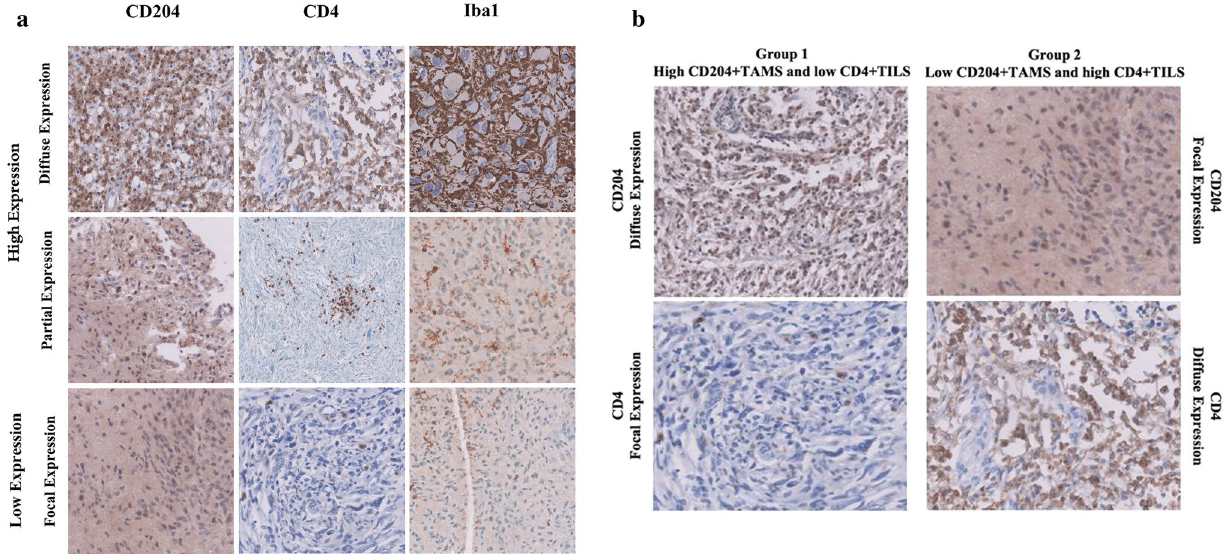
Fig. 1 Quantitative assessment of CD204 + TAMs, CD4 + TILs, and Iba1 + microglial activation in glioblastoma microenvironment using IHC. a Staining expression was quantitively analysed and subclassified into categories as described in Table 2, b Staining expression of the two groups: group 1 high expression of CD204 + TAMs with low expression CD4 + TILs, group 2: low expression of CD204 + TAMs with high expres- sion CD4 + TILs